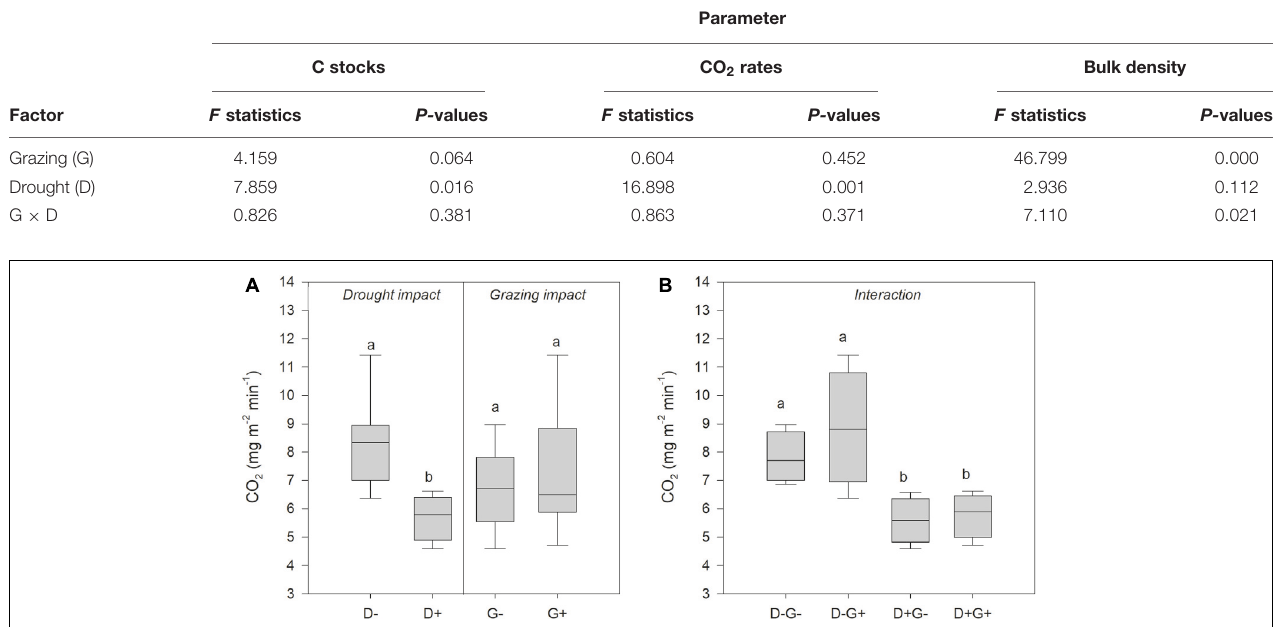
TABLE 1 | Full factorial ANOVA, F statistics, with P -values showing how C stocks, CO 2 emission rates and bulk density were influenced by grazing (G), drought (D), and the interaction of grazing and drought (G × D).